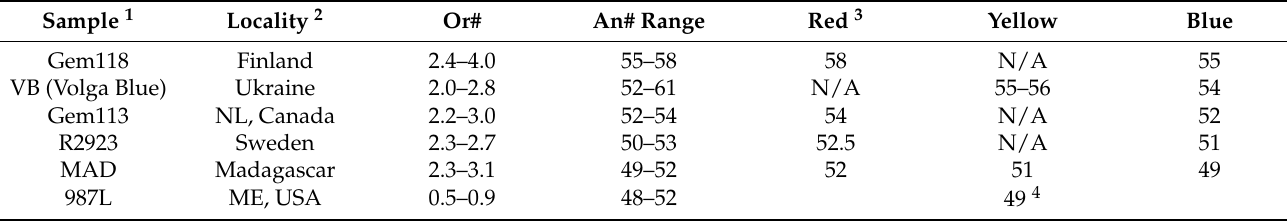
Table 1. Names, provenances, composition ranges, and compositions of individual color zones of the samples studied in this